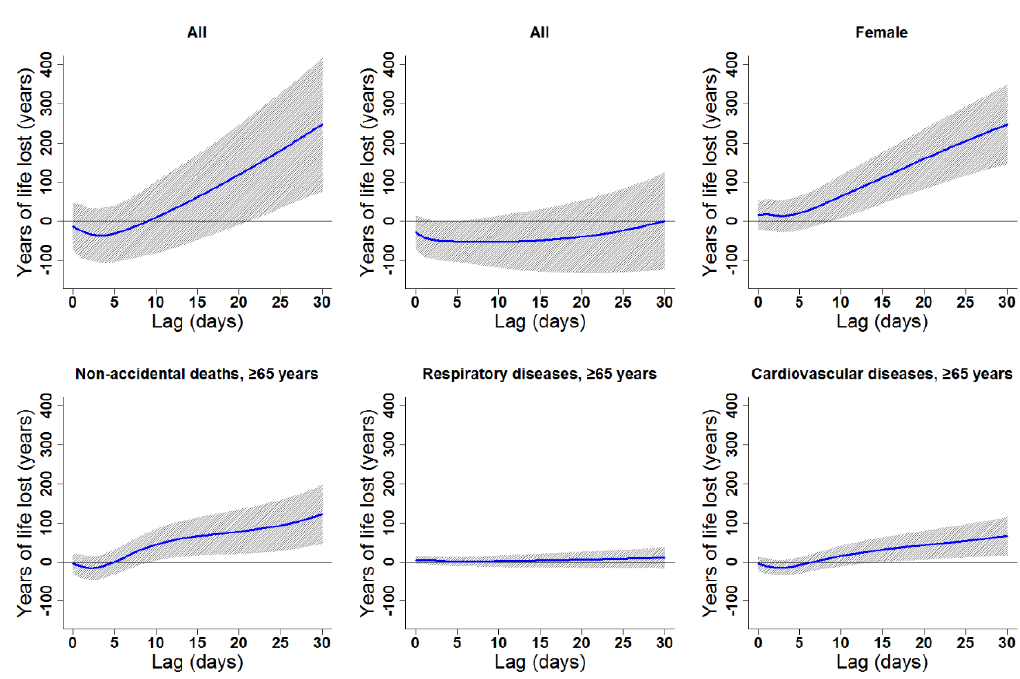
Figure 6. Lag patterns for cumulative cold effects on various subgroups in Lanzhou, China. The bold lines represent the effect estimates, and the grey areas represent 95% confidence intervals. Cold effects in the present study represented changes in YLL caused by lower temperatures from the 25th to the 1st percentile of the overall temperature distribution. The reference temperature was 2.45 °C (25th percentile).